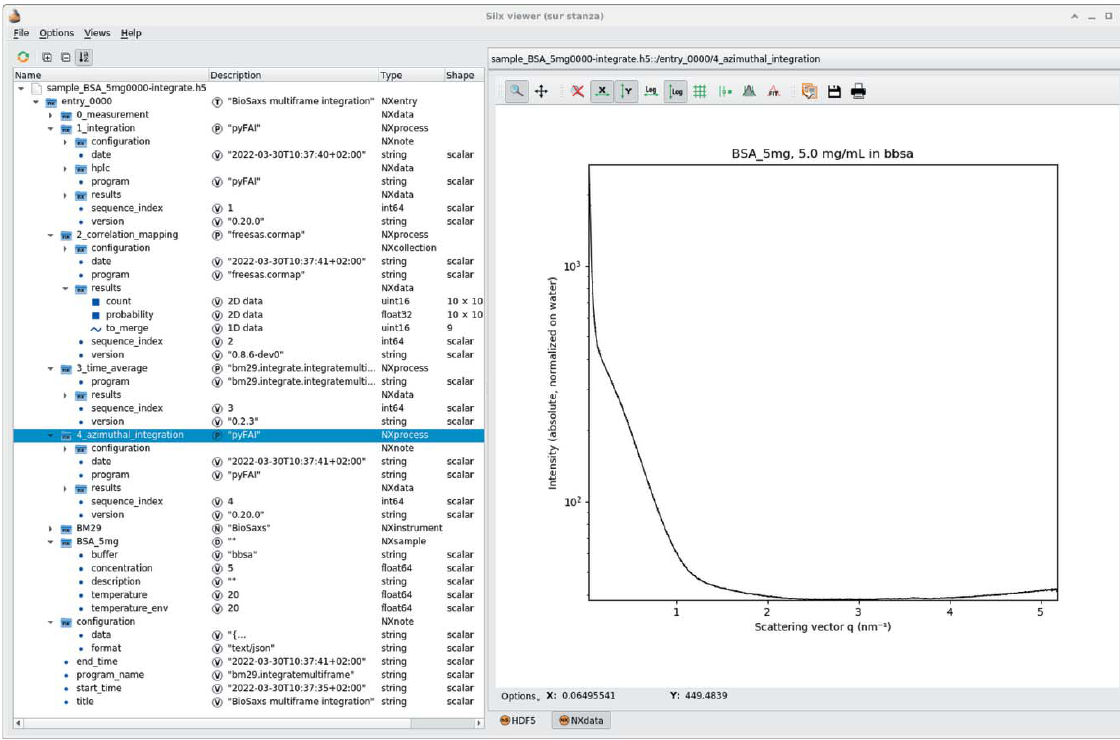
Figure 5 Layout of an HDF5 file obtained from the multi-frame integration pipeline, visualized with the silx viewer. The HDF5 tree structure (left-hand side) follows the pipeline described in Fig. 4. The right-hand-side plot is the averaged scattering curve I = f ( q ) on a semi-logarithmic scale of the macromolecule (BSA) before subtraction of the background